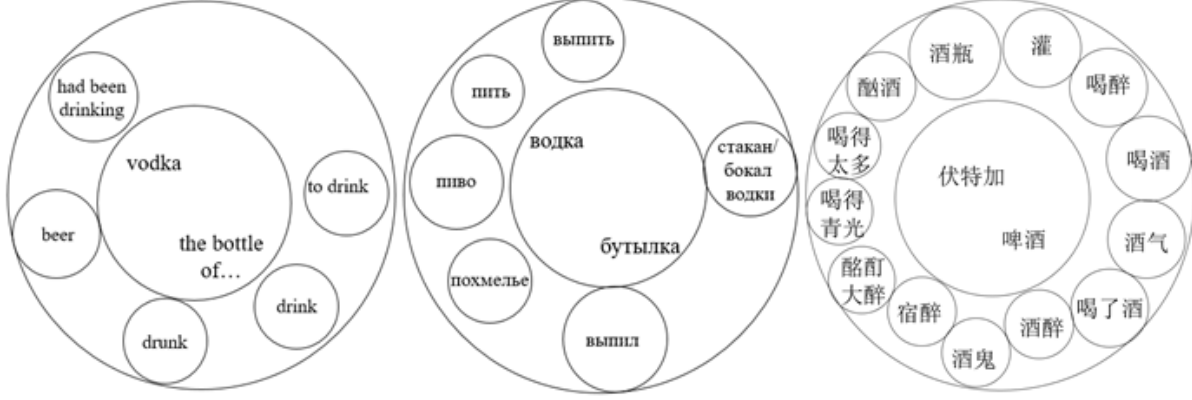
Figure 2 – Structure of the concepts Alcohol addiction, АЛКОГОЛЬНАЯ ЗАВИСИМОСТЬ and 酒 瘾 Represenation of the concepts Alcohol addiction, АЛКОГОЛЬНАЯ ЗАВИСИМОСТЬ has similarities both in the core of the concept and on the periphery, but in the Chinese text the core or the nuclear of the concept 酒 瘾 is different: instead of the container (the bottle of…) a second drink appears ( 啤酒 – beer) (see Figure 2). The periphery of the concept is also different, it is presented more widely. O. A. Myshakova and Li Juan use the means of direct nomination, and very rarely resort to descriptive translation, metaphors, or other means of artistic